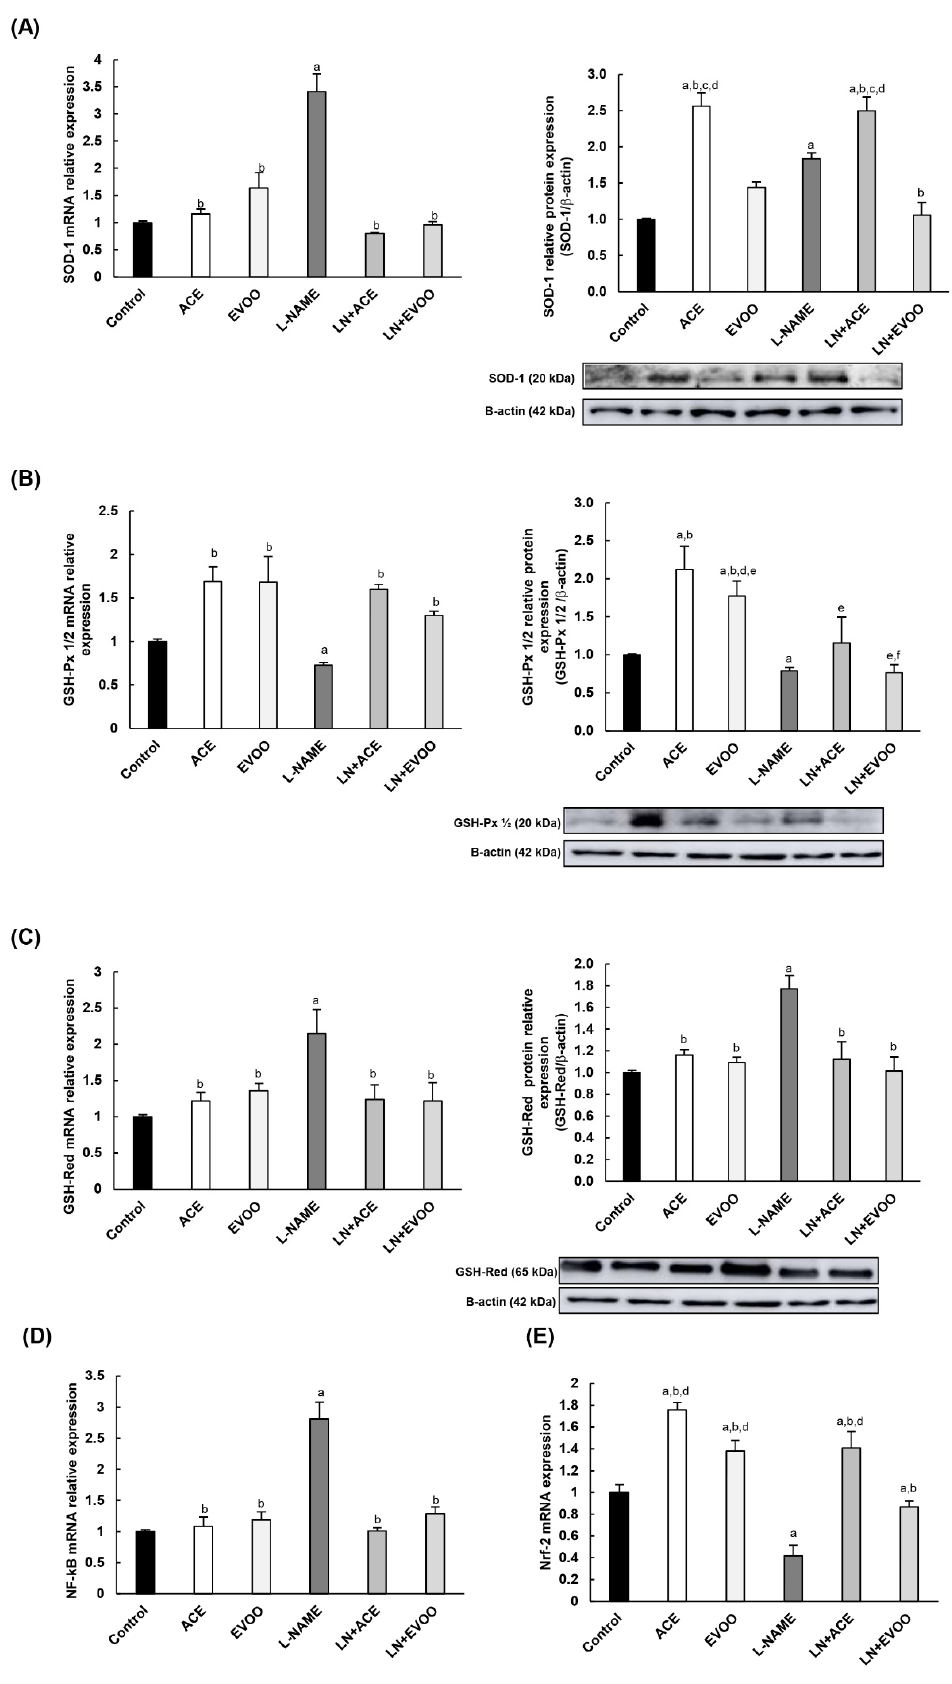
Figure 7. Antioxidant enzyme gene and protein expression of ( A ) superoxide dismutase (SOD-1), ( B ) glutathione peroxidase (GSH-Px) 1/2, and ( C ) glutathione reductase (GSH-Red) in retina homogenates from each experimental animal group. mRNA expression of transcription factors nuclear factor kappa-B (NF-kB) ( D ) and nuclear factor erythroid-2 (Nrf-2) ( E ) in the retina. The quantitative fold changes in gene expression were determined relative to GAPDH in each corresponding group. Values are expressed as mean ± SEM of four animals per group: a p < 0.05 vs. control; b p < 0.05 vs. L-NAME; c p < 0.05 vs. EVOO; d p < 0.05 vs. LN+EVOO; e p < 0.05 vs. ACE; f p < 0.05 vs. LN + ACE. 4. Discussion Despite the well-known healthy effects of the Mediterranean diet and EVOO in particular, very little is known about the properties of other varieties of OOs, such as ACE (wild olive) oil. The chemical composition profile of the oils used in this study, i.e., ACE oil and EVOO (which were obtained from the same geographic area and processed following equal protocols) revealed a similar fatty acid composition, but interesting differences at the level of minor components. Thus, the unsaponifiable fraction from ACE oil was richer than that of EVOO in sterols, tocopherols, triterpene acids, alcohols and secoiridoids. Both sterols and tocopherols are well-known essential micronutrients in the diet of all mammals, with potent hypolipidemic and antioxidant capacities [49– 51]. Furthermore, the proportion of triterpene acids in ACE is remarkable, considering the antioxidant and neuroprotective effects associated with maslinic acid, among others [52,53] Despite the fact that the phenol content is similar in both oils, they showed an inverted ratio ortodiphenol/secoiridoids, the latter being the main polyphenols in ACE oil. A variety of pharmacological effects has been reported for these compounds against different pathologies related to inflammatory and oxidant events, due to their antidiabetic, antioxidant, anti-inflammatory, immunosuppressive, neuroprotective, anticancer, and anti-obesity properties [54–57]. Therefore, our findings on the chemical composition of ACE oil and EVOO suggest a different behavior in terms of health protection. Experimental treatment with L-NAME is a well-established model of AH. The administration of oil-enriched diets and/or L-NAME did not affect food/water intake nor weight gain throughout the 6-week experimental period. As expected, a significant and sustained elevation of SBP and DBP was found in the L-NAME group [45]. Interestingly, hypertension was alleviated in L-NAME-treated animals subjected to simultaneous administration of ACE oil- and EVOO-enriched diets, but a clearly higher depletion of blood pressure was observed in the former. Olive polyphenols have been associated with positive blood pressure outcomes [58]; additional experiments carried out in our lab showed an improvement in endothelial function, vascular remodeling and hypertrophy in aortas from hypertensive animals upon administration of an ACE oil-enriched diet (unpublished results). Since no changes were found in total phenol content between both oils, the higher hypotensive effect observed for the ACE oil diet might perhaps be attributable to its elevated secoiridoid compound content.